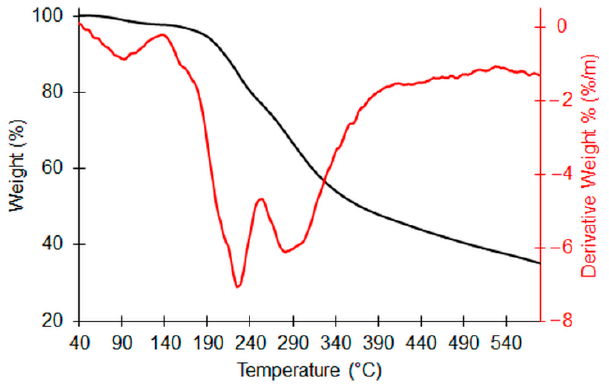
Figure 3. TGA (black line) and DTGA (red line) of OFE.